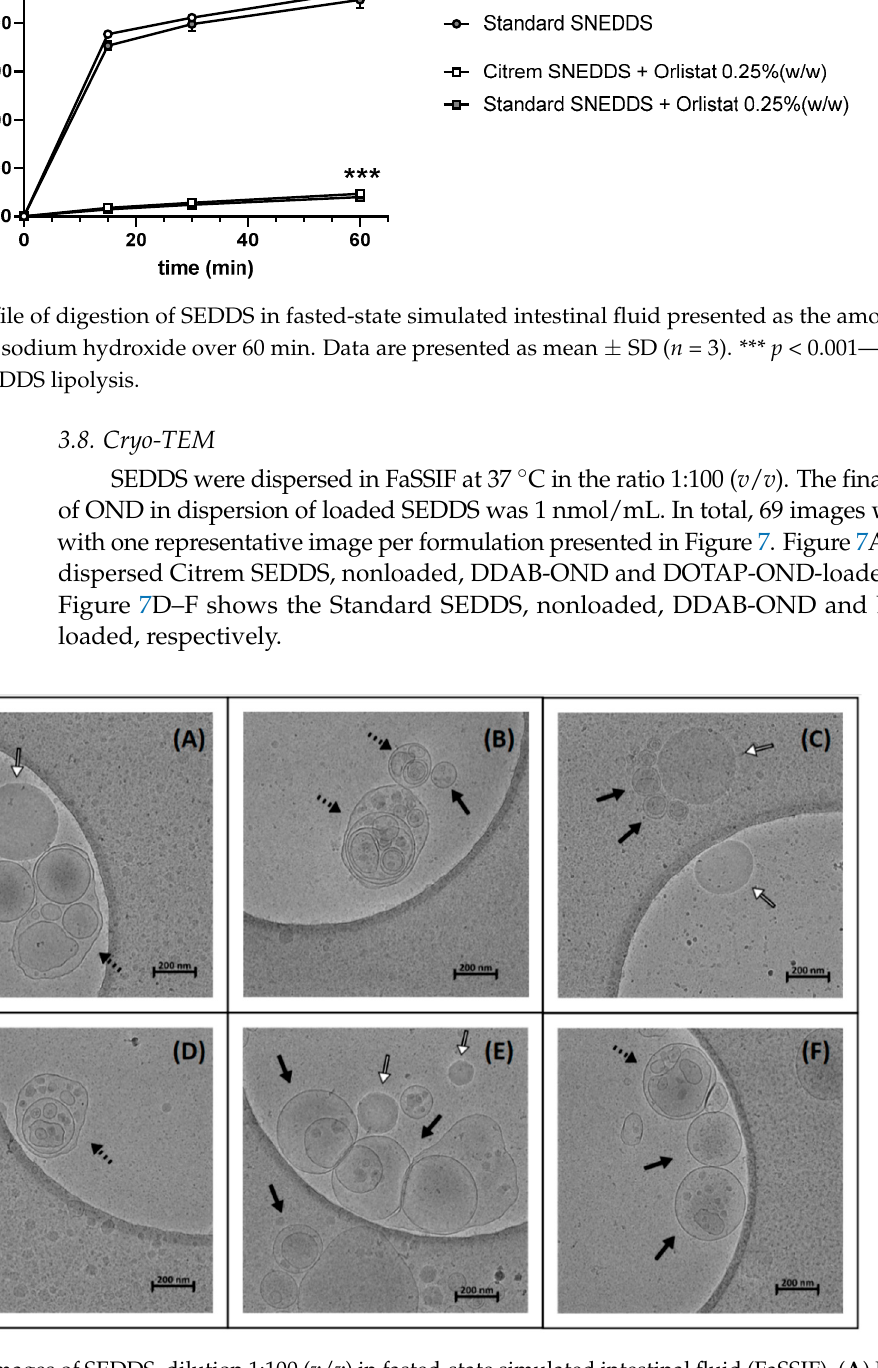
Figure 7. Cryo-TEM images of SEDDS, dilution 1:100 ( v / v ) in fasted-state simulated intestinal fluid (FaSSIF). ( A ) Nonloaded Citrem SEDDS, ( B ) DDAB-OND-loaded Citrem SEDDS (100 nmol/g), ( C ) DOTAP-OND-loaded Citrem SEDDS (100 nmol/g), ( D ) nonloaded Standard SEDDS, ( E ) DDAB-OND-loaded Standard SEDDS (100 nmol/g) and ( F ) DOTAP-OND-loaded Citrem SEDDS (100 nmol/g). Full arrows indicate uni- and multilamellar vesicles, dashed arrows indicate more complex vesicular structures and open arrows indicate oil droplets.